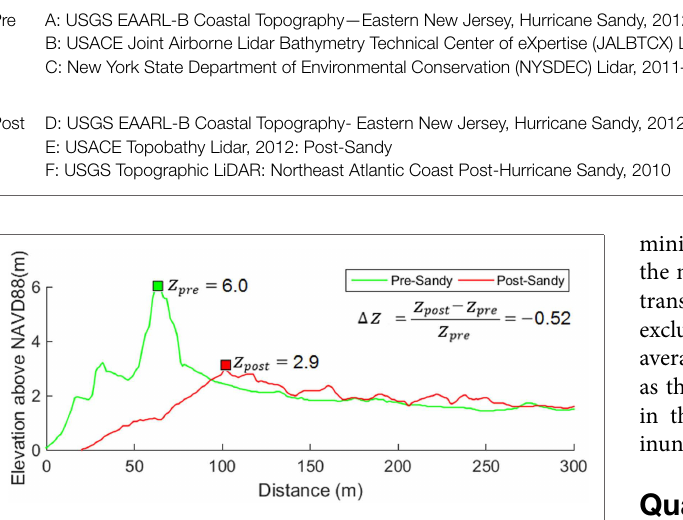
both flood inundation and wave action along the transect noted in Section “Hindcast